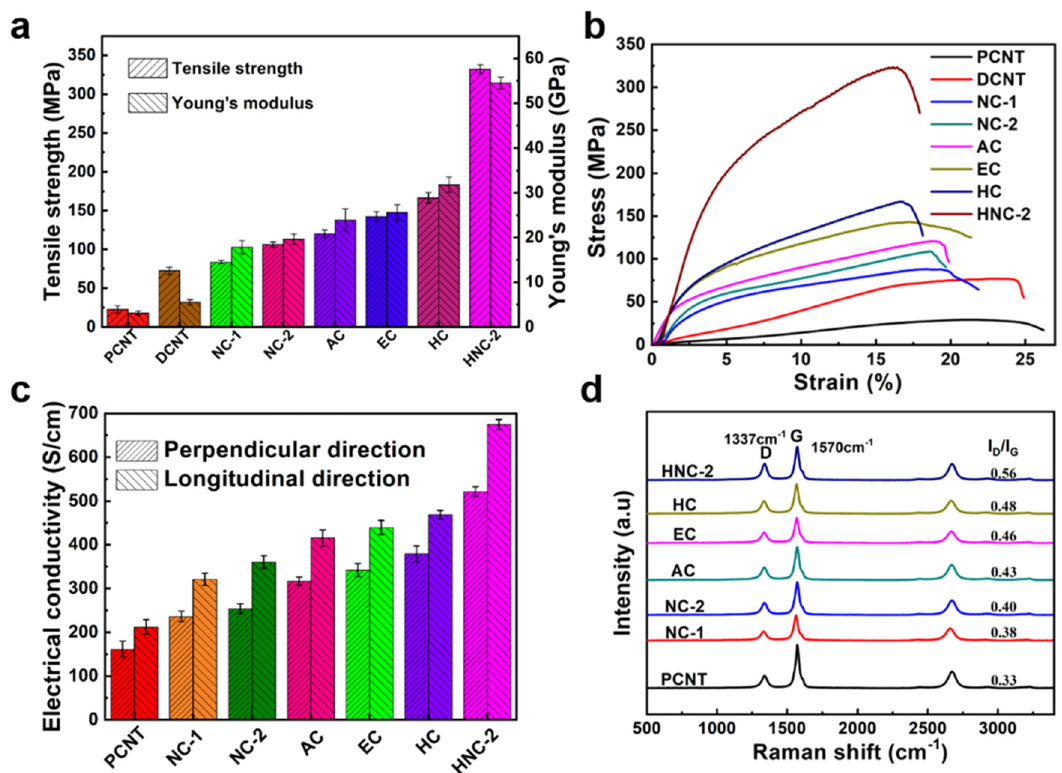
Figure 4: Properties of pristine and modi fi ed CNT fi lms: ( a ) tensile strength, ( b ) stress – strain curves, ( c ) electrical conductivity, and ( d ) Raman spectra.